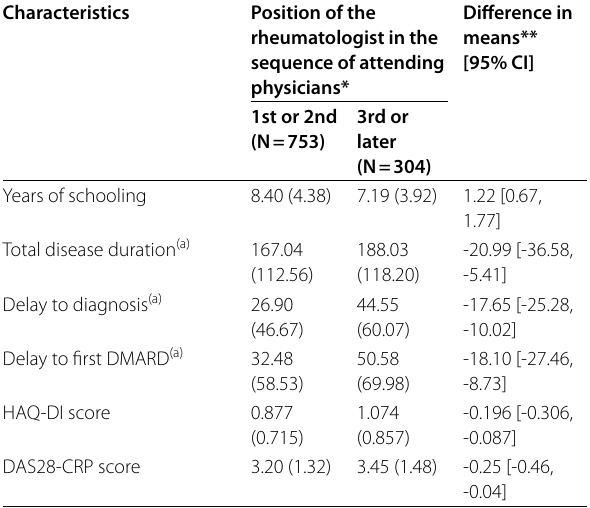
Table 4 Comparisons between patients with RA according to access to the rheumatologist in the diagnostic journey Characteristics Position of the rheumatologist in